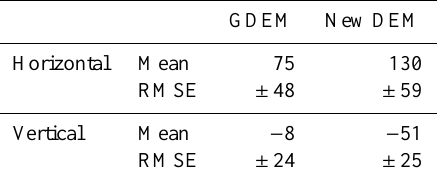
Table 4a. Relative errors. Values are a summary of the di ff erences relative to SPIRIT DEMs for ∼ 60 points distributed across the Antarctic Peninsula (in metres).